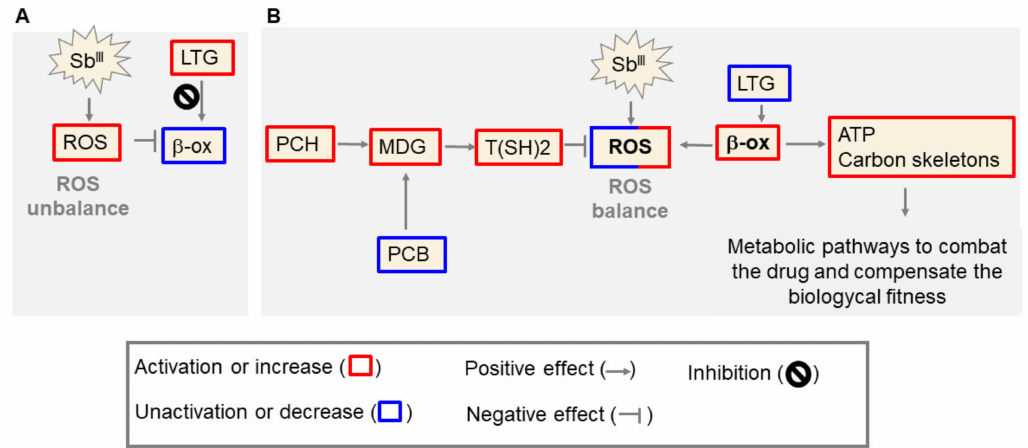
Figure 12. Model of antimony resistance in Leishmania parasites at the lipidomic level. ( A ) The antimony (Sb III ) induces reactive oxygen species (ROS) production and β -oxidation ( β -ox) inhibition, causing accumulation of triglycerides with more long chains fatty acids (LTG) and a poor energy metabolism. ( B ) To combat those alterations, resistant parasites rescue methyl donor groups (MDG) such as SAM and DMG. This strategy involves PC biosynthesis decrease (PCB) and/or the increase of PC hydrolysis (PCH). Higher MDGs levels improve the thiol (R-SH) metabolism and the downstream reaction of trypanothione T(SH)2 synthesis required to reach a ROS balance. The successful antioxidant response offers the opportunity for the controlled activation of pathways ROS generators, such as the β -ox. The β -ox can use the fatty acids from LTG to produce ATP and carbon skeleton, which are required to activate the metabolic pathways involved in both the drug control (drug sequestration, drug metabolism or drug efflux) and the biological fitness